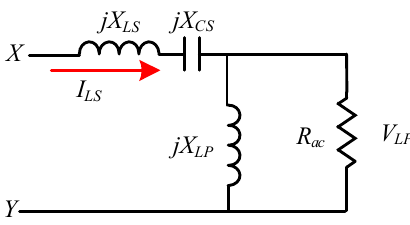
Figure 4. Phasor equivalent circuit for LLC resonant converter by using FHA .